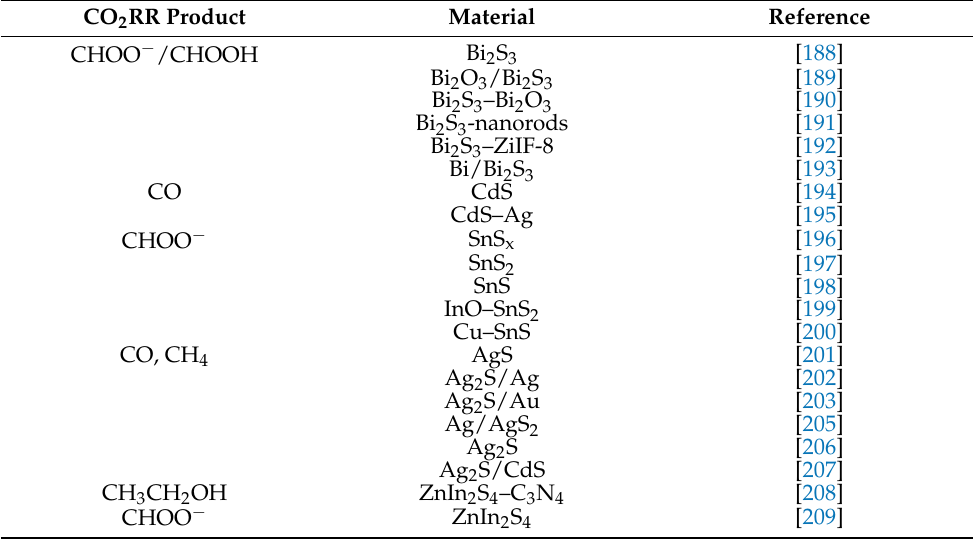
Table 3. Summary of products in the CO 2 RR using various sulfides from the later transition/metal elements nanomaterials and their associated composite